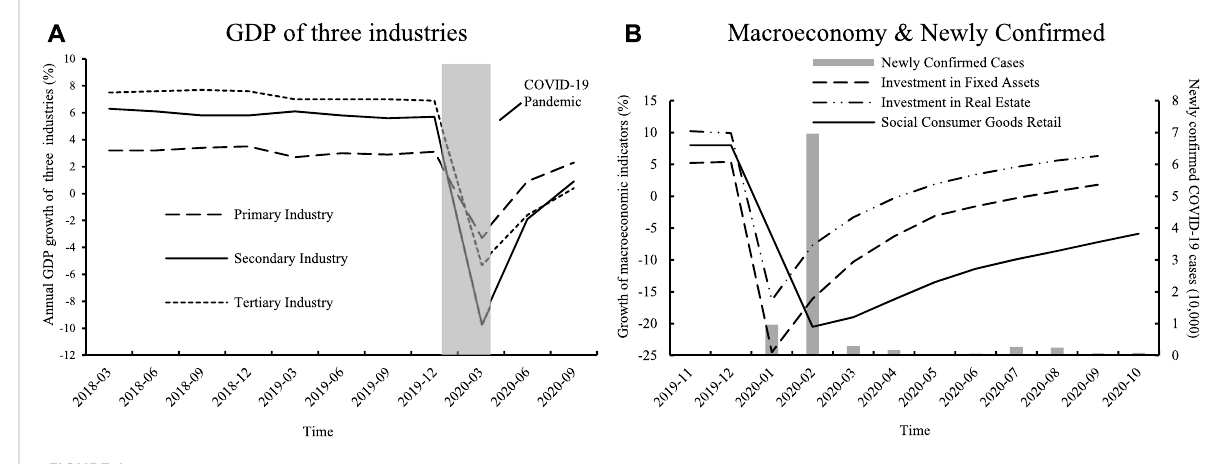
FIGURE 1 The situation of the national economy during COVID-19. Notes: In this fi gure, the vertical axis indicates annual growth rate of GDP in three industries (including primary industry, secondary industry and tertiary industry), annual growth rate of macroeconomic indicators (including investment in fi xed assets, investment in real estate and social consumer goods retail) and newly con fi rmed cases of COVID-19. The horizontal axis presents the time from March 2018 to September 2020 and the time from November 2019 to October 2020. (A) GDP of three industries (B) Macroeconomy and Newly Con fi